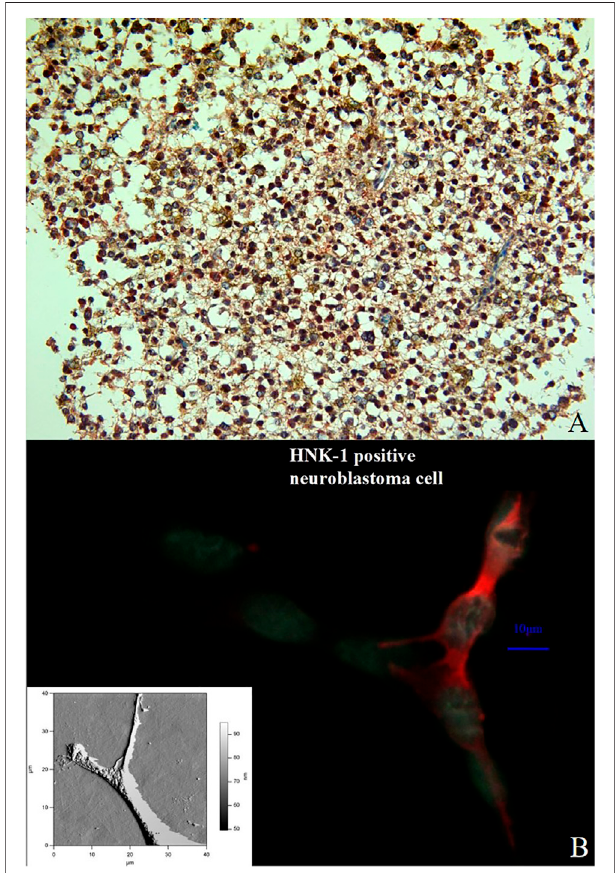
FIGURE 11 | Double immunostaining with the antibodies against ADAM12 (red color) and GFAP (brownish color) in a previously diagnosed oligoastrocytoma WHO grade II. Immuno-histochemistry for these markers identi fi es and labels two distinct though intermixed tumor-cell populations; the oligodendroglioma cells stain positive for ADAM12 whereas the astrocytoma cells for GFAP. (Magni fi cation × 200) (A) . Comparison betweenanimmunestainedneuroblastomacell(theHNK-1epitopeisstained in red) and an AFM presentation of a neuroblatoma cell of the same cell line (lower left corner). The relation between NCAM and β 1-integrinin neuroblastoma cells was performed by an immune staining for both molecules (B)